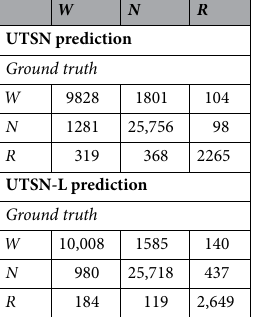
Table 2. Confusion matrix analysis from testing. Values, total epoch count from 22 recordings; Shaded cells, true positive; W wakefulness, N NREM, R